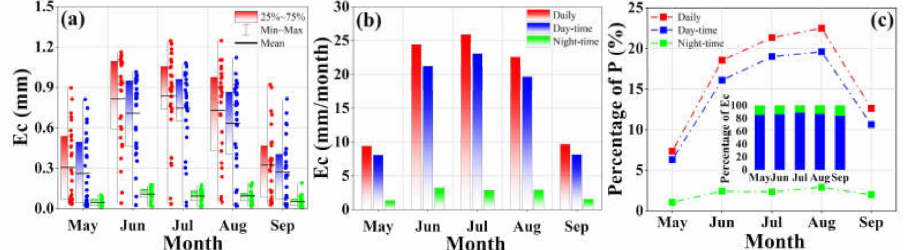
Figure 6. Plot showing the monthly dynamics of Ec in growing season. ( a ) mean daily Ec; ( b ) monthly Ec; ( c ) Percentage of P.